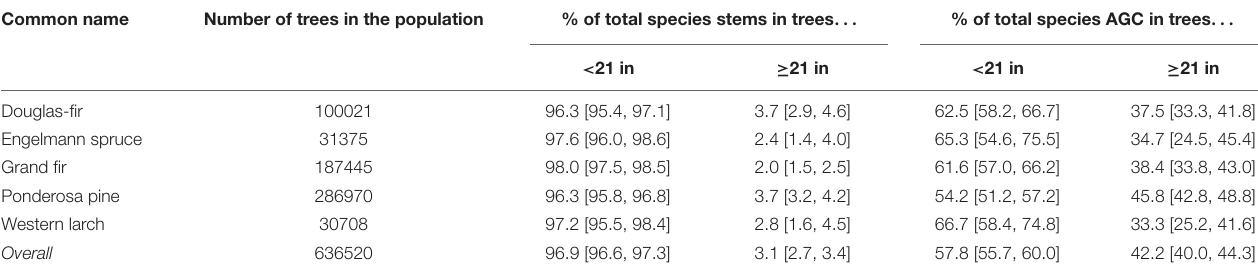
Table 5 ). Grand fir from cool-moist and warm-dry